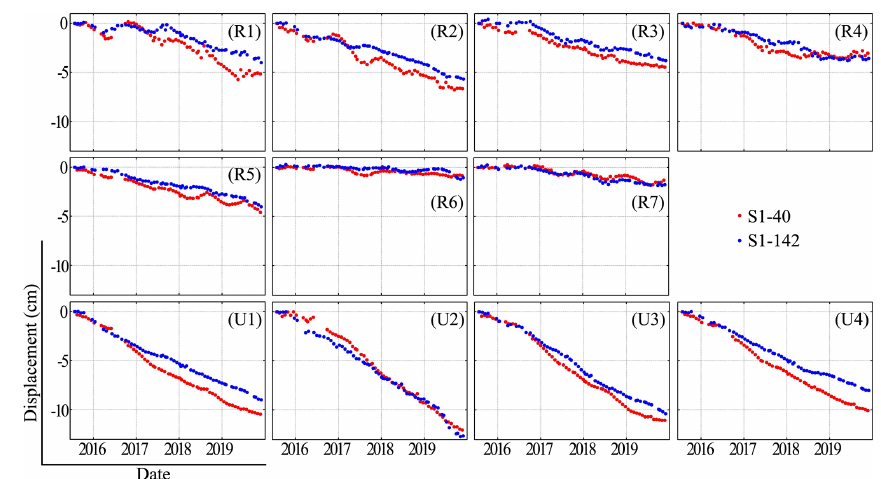
Figure 6. Time-series displacement of MPs located in rural areas (R1–R7) and urban areas (U1–U4) shown in Fig. 5.